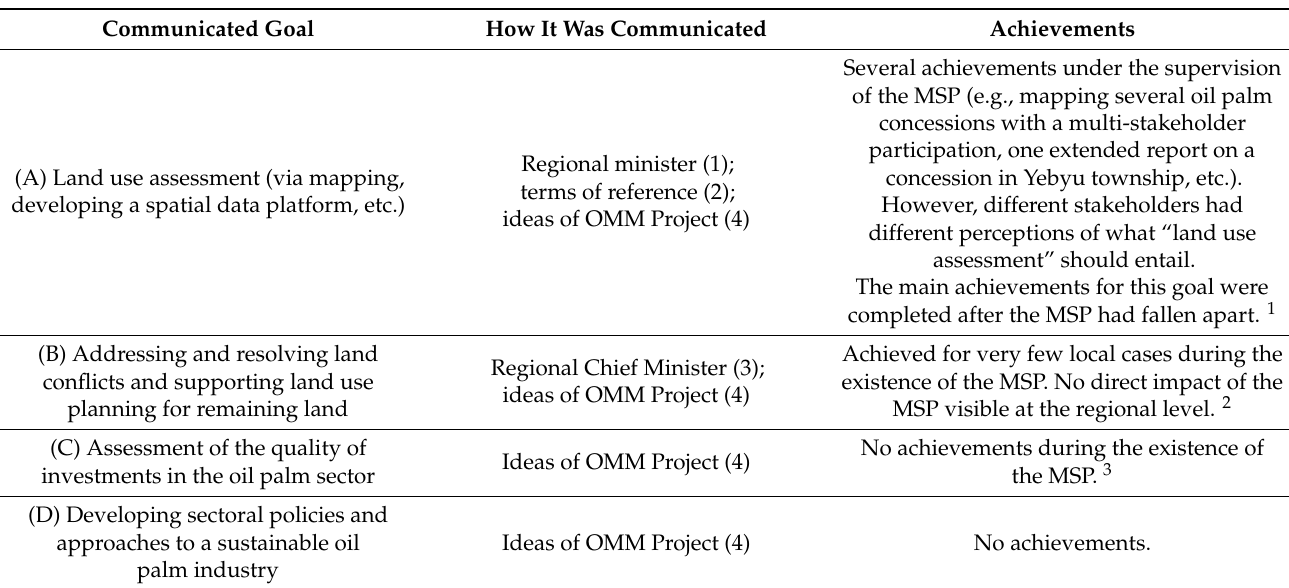
Table 4. Effectiveness of the MSP, interpreted by comparing the communicated overall goals and respective